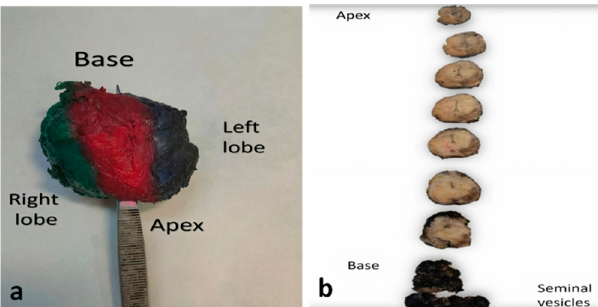
Figure 1. Gross handling of prostatectomy specimens ( a ) Prostate specimen, colored with different colors in each surface to help orientation. ( b ) Serial sectioning through the transverse axis from apex to base (margins colored with blank ink). Apex and base will be subsequently sectioned in a parallel (parasagittal) way (not shown).